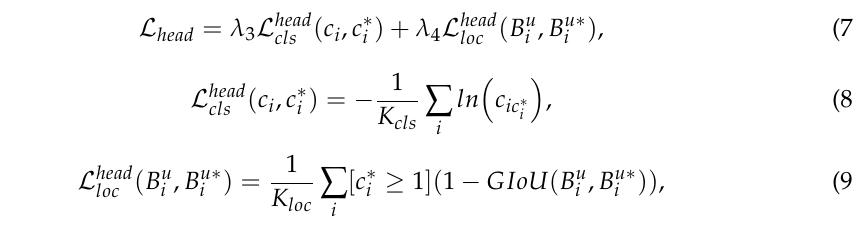
Table 1. The image sizes range from 492 × 756 to 1024 × 2048 pixels. It is noteworthy that most objects occupy small portions of images (Figure 5). About 73.21% of instances are small objects which occupy less than 1% of image area, and 19.41% of instances occupy 1~2% of the total area of